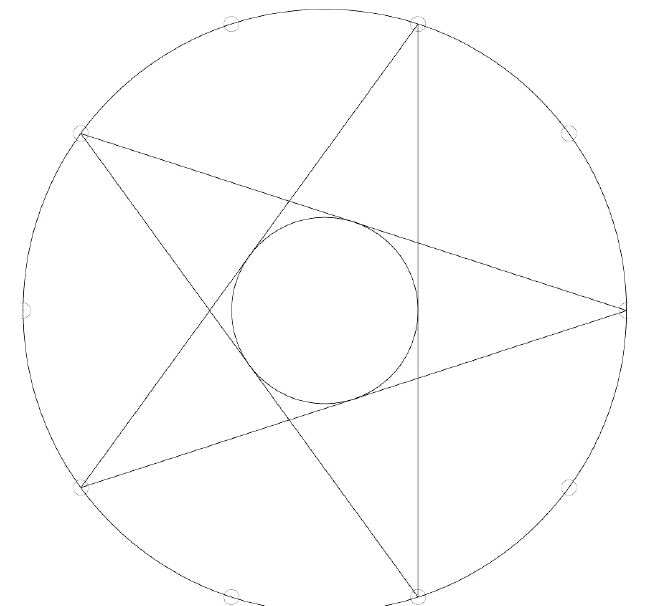
Figure 22. Pentagram based on a circle of radius Phi superimposed on a circle with a diameter of